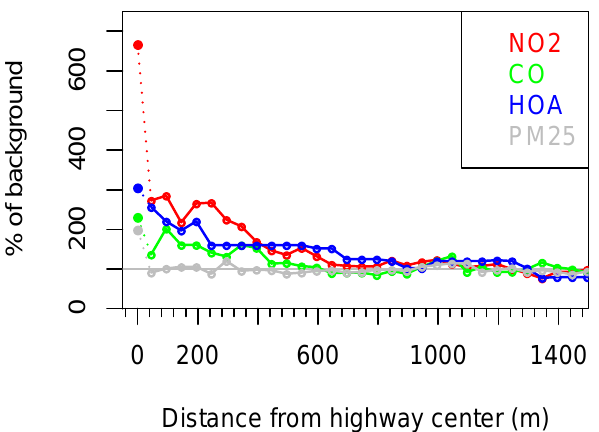
Figure 6. Normalized cross sections of NO 2 , CO, HOA and PM 2 . 5 along the cross section described in the text and Fig. 5. Calculated as the median at each distance divided by the average of the 1000– 1500m medians. Leftmost points at distance 0 mark measurements taken passing through the